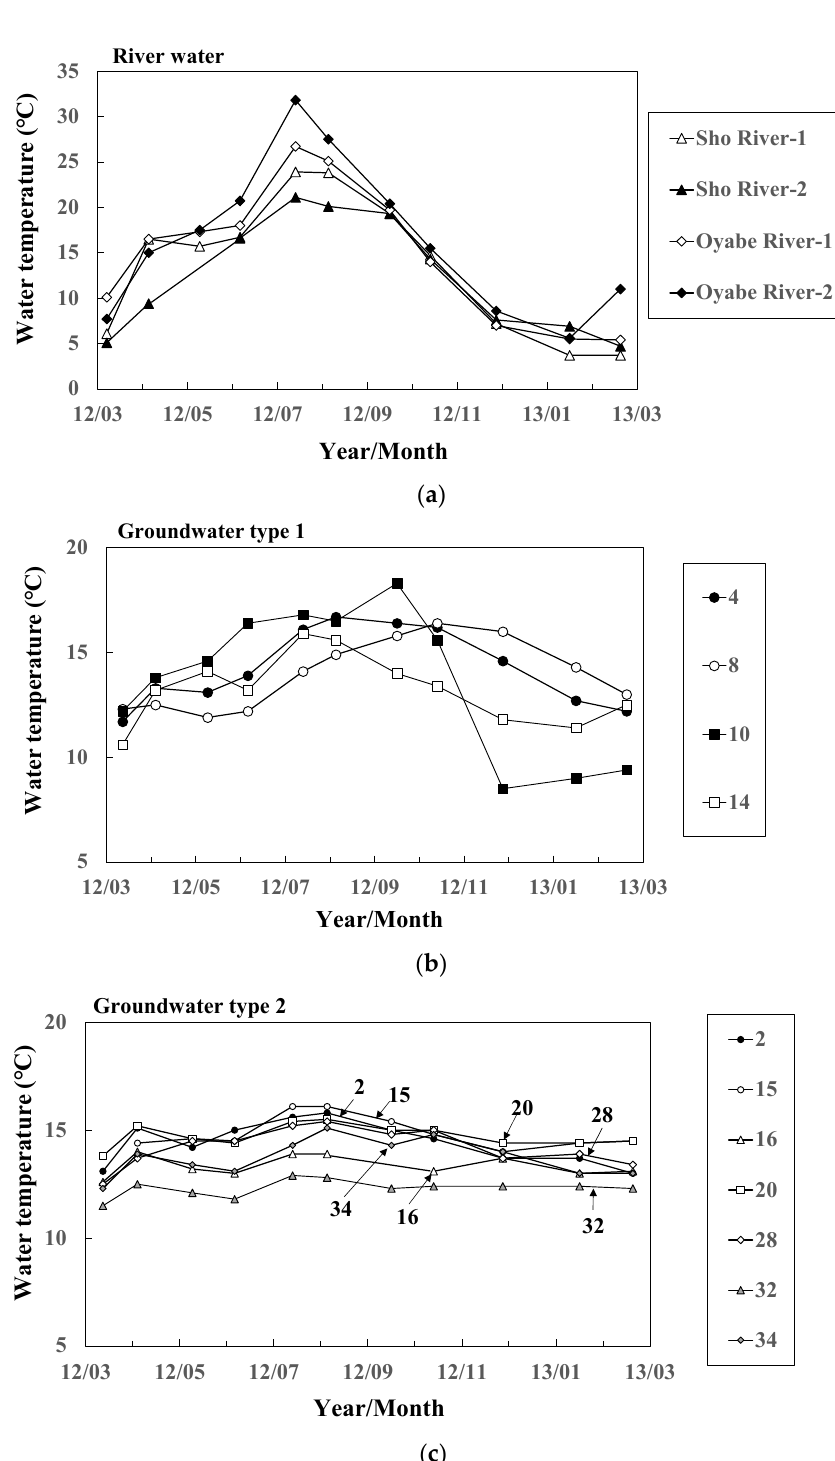
Figure 3. Seasonal variation of water temperature of ( a ) river water and groundwater (( b ) Types 1 and ( c ) 2 at 11 representative sites.